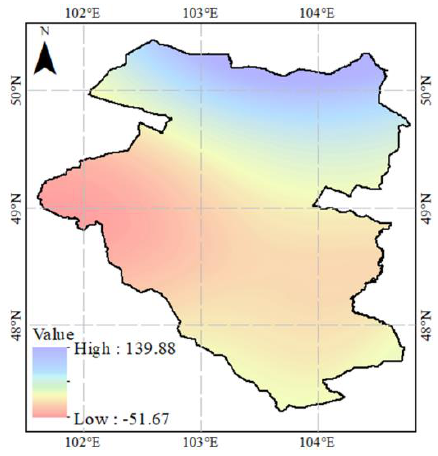
Figure 8. Percentage of average annual change in RUE (June, July, and August of 2000-2018).